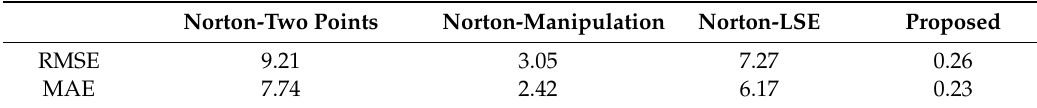
Table 4. Comparisons between the proposed method and Norton-based methods for 5th harmonic current w.r.t. RMSE and MAE.